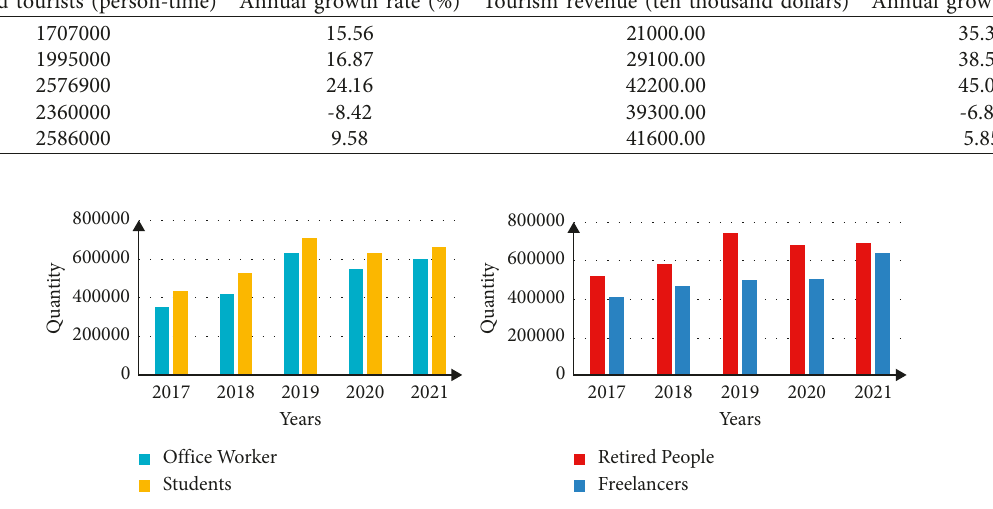
Figure 7: Statistics of the number of occupational types of tourists in city A from 2017 to 2021.